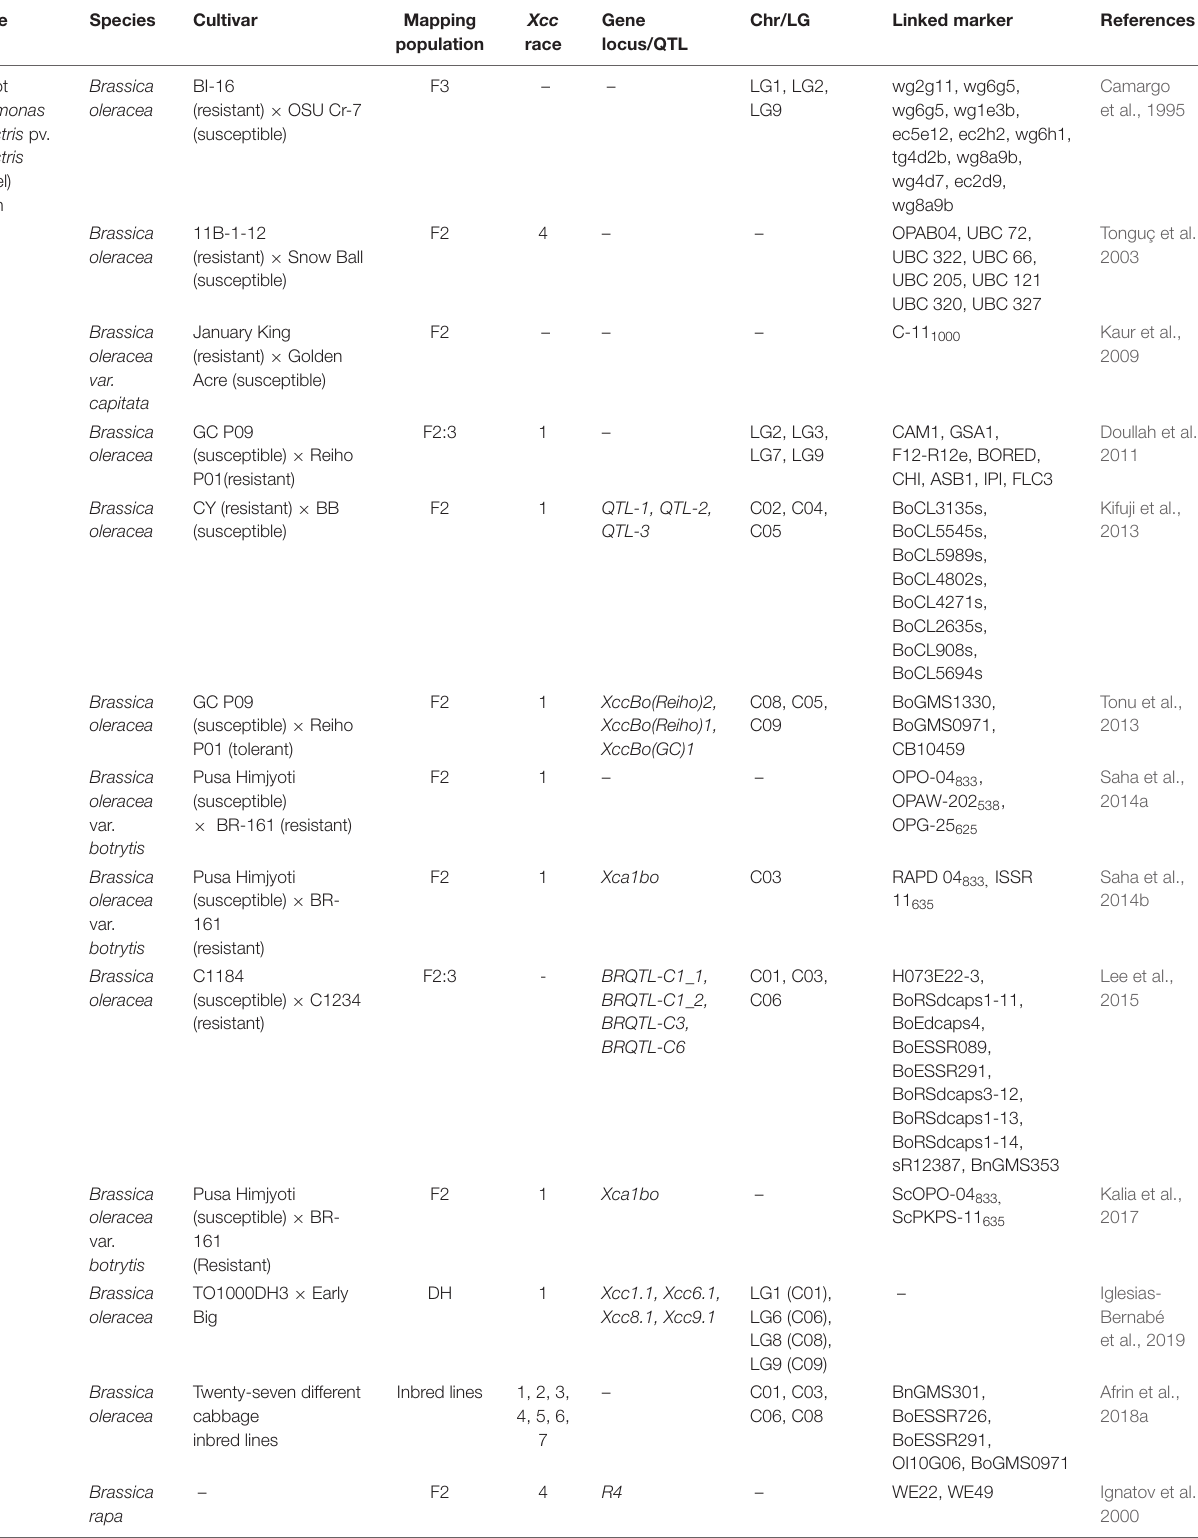
TABLE 1 | List of quantitative trait loci (QTLs)/R-genes associated with black rot resistance in Brassica oleracea and related Brassica species. Disease Species